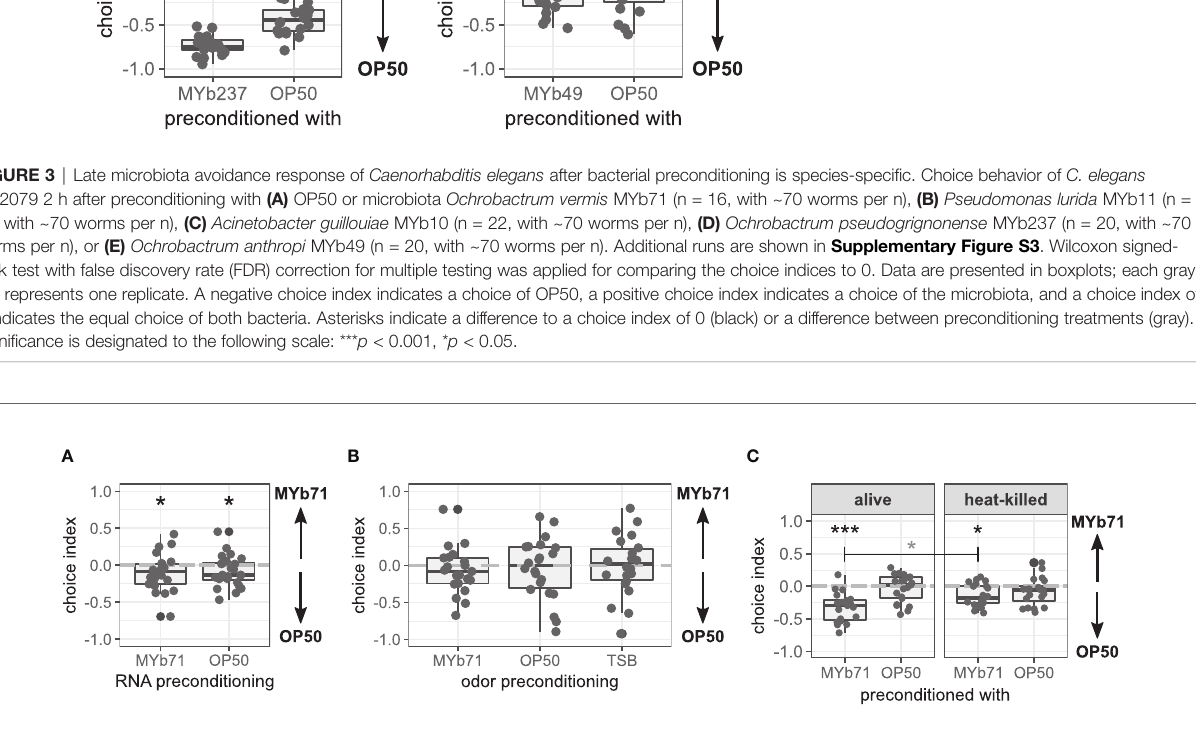
FIGURE 4 | Late microbiota avoidance response is independent of total RNA of MYb71 or MYb71 odor but is more pronounced with viable MYb71. (A) Choice behavior after preconditioning with RNA of MYb71 or OP50 applied to viable OP50 (n = 24, with ~70 worms per n); or (B) after preconditioning with the odor of MYb71, OP50, or TSB (n = 22, with ~70 worms per n); or (C) after preconditioning with alive or heat-killed MYb71 or OP50 (n = 20, with ~70 worms per n). A negative choice index indicates the choice of OP50, a positive choice index indicates the choice of MYb71, and a choice index of 0 indicates the equal choice of both bacteria. Wilcoxon signed-rank test, false discovery rate (FDR)-corrected. Data are presented in boxplots; each gray dot represents one replicate. Asterisks indicate a difference to a choice index of 0 (black) or difference between treatments (gray). Signi fi cance is designated to the following scale: *** p < 0.001, * p <